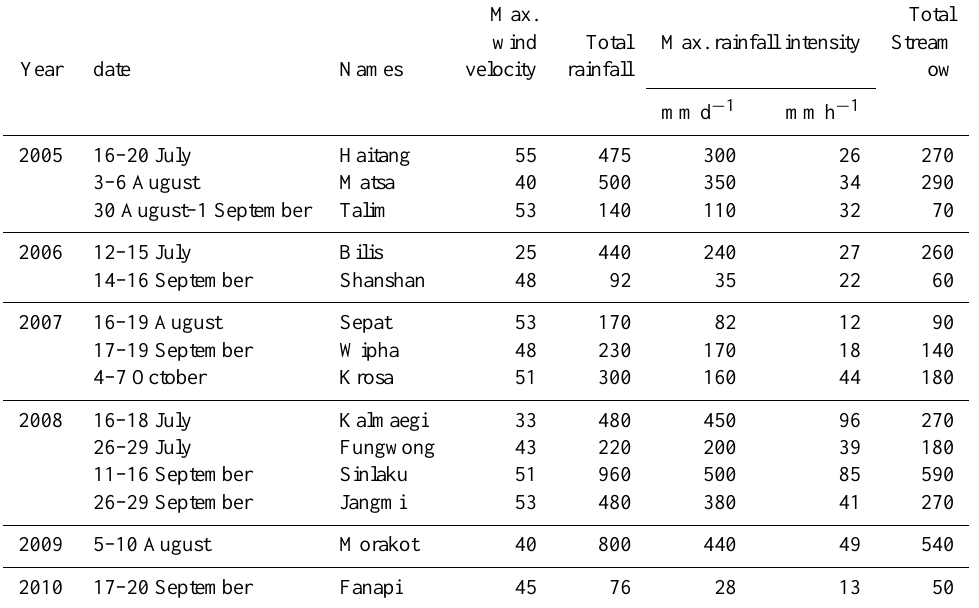
Table 1. Wind velocity (ms − 1 ) at the typhoon centre, and rainfall (mm) and stream flow (mm) of typhoons between 2005 and 2010 at Lienhuachi Experimental Forest.